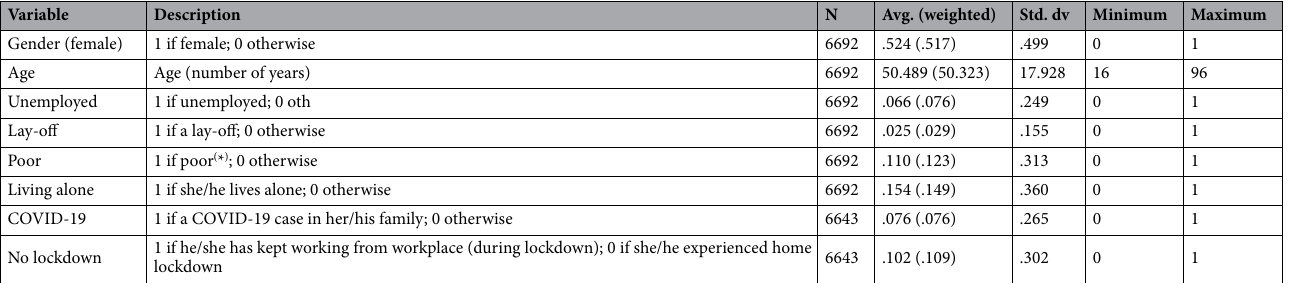
Table 3. Summary statistics of independent variables (weighted and not weighted). ( * ) “Poor” is defined from a 5-point Likert scale as the worst economic condition, in which the individual experiences severe economic difficulties, lacking sufficient money to live at a normal standard (in 2019, the Italian Statistical Office has estimated that 7.7% of Italian individuals could be regarded as poor; however, this values has sharply increased in 2020 due to the economic crisis related to the COVID-19 pandemic).